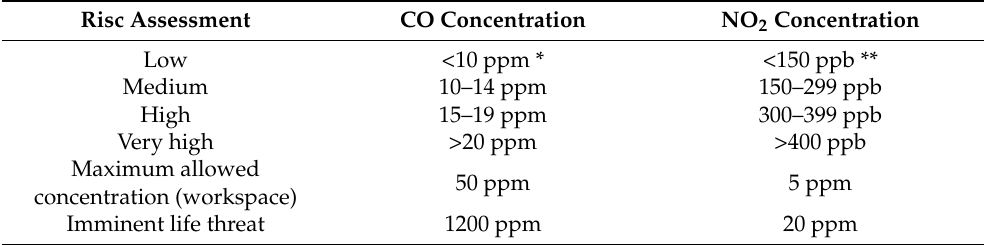
Table 2. Typical values for pollutants in air